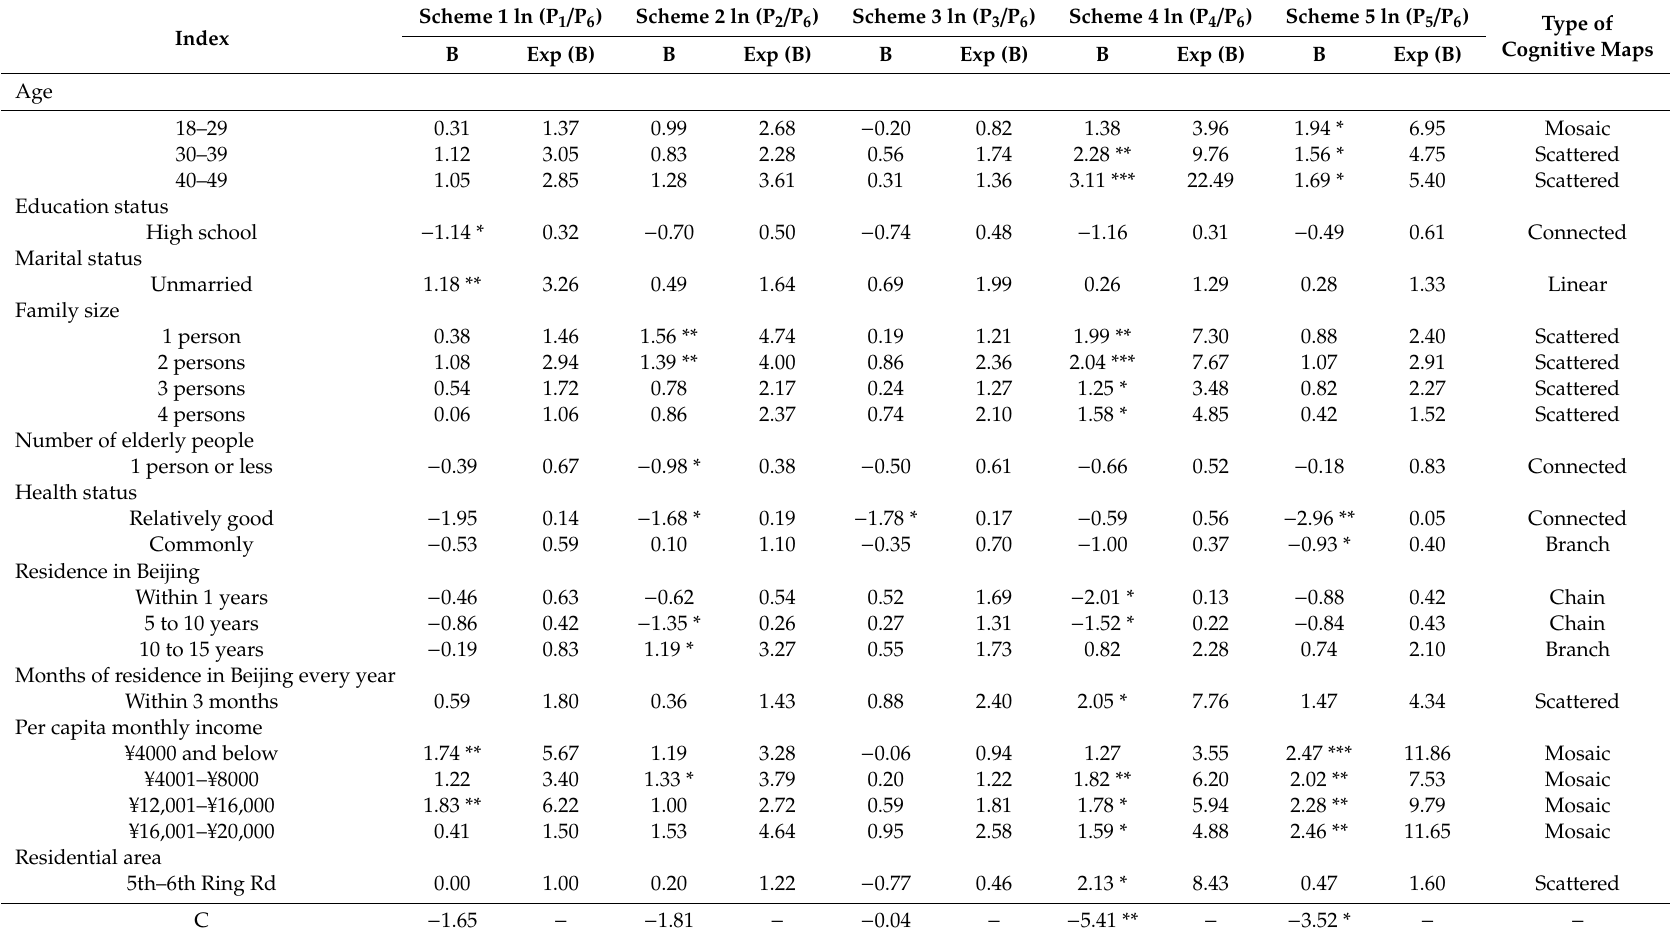
Table 6. Results of maximum likelihood estimates for the MNL